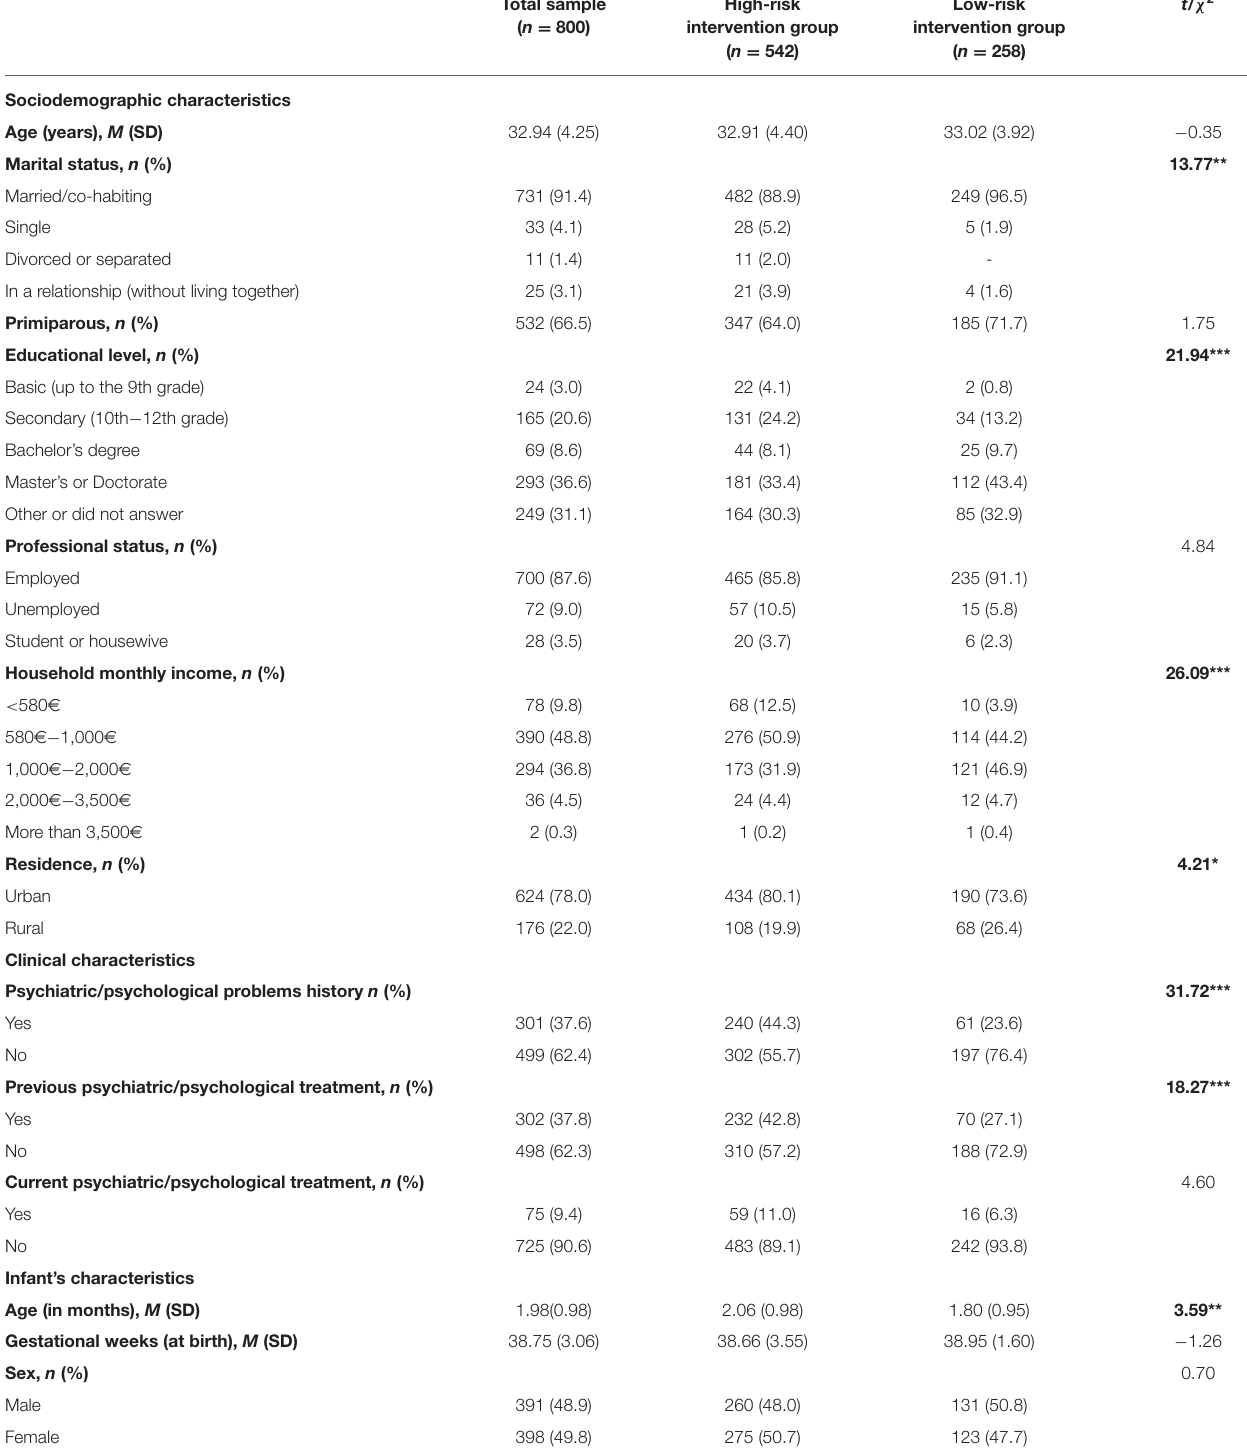
TABLE 1 | Participants’ sociodemographic and clinical characteristics at